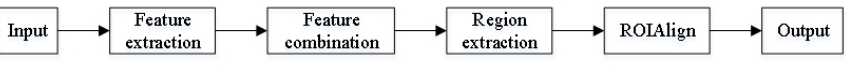
Fig. 1. Mask R-CNN